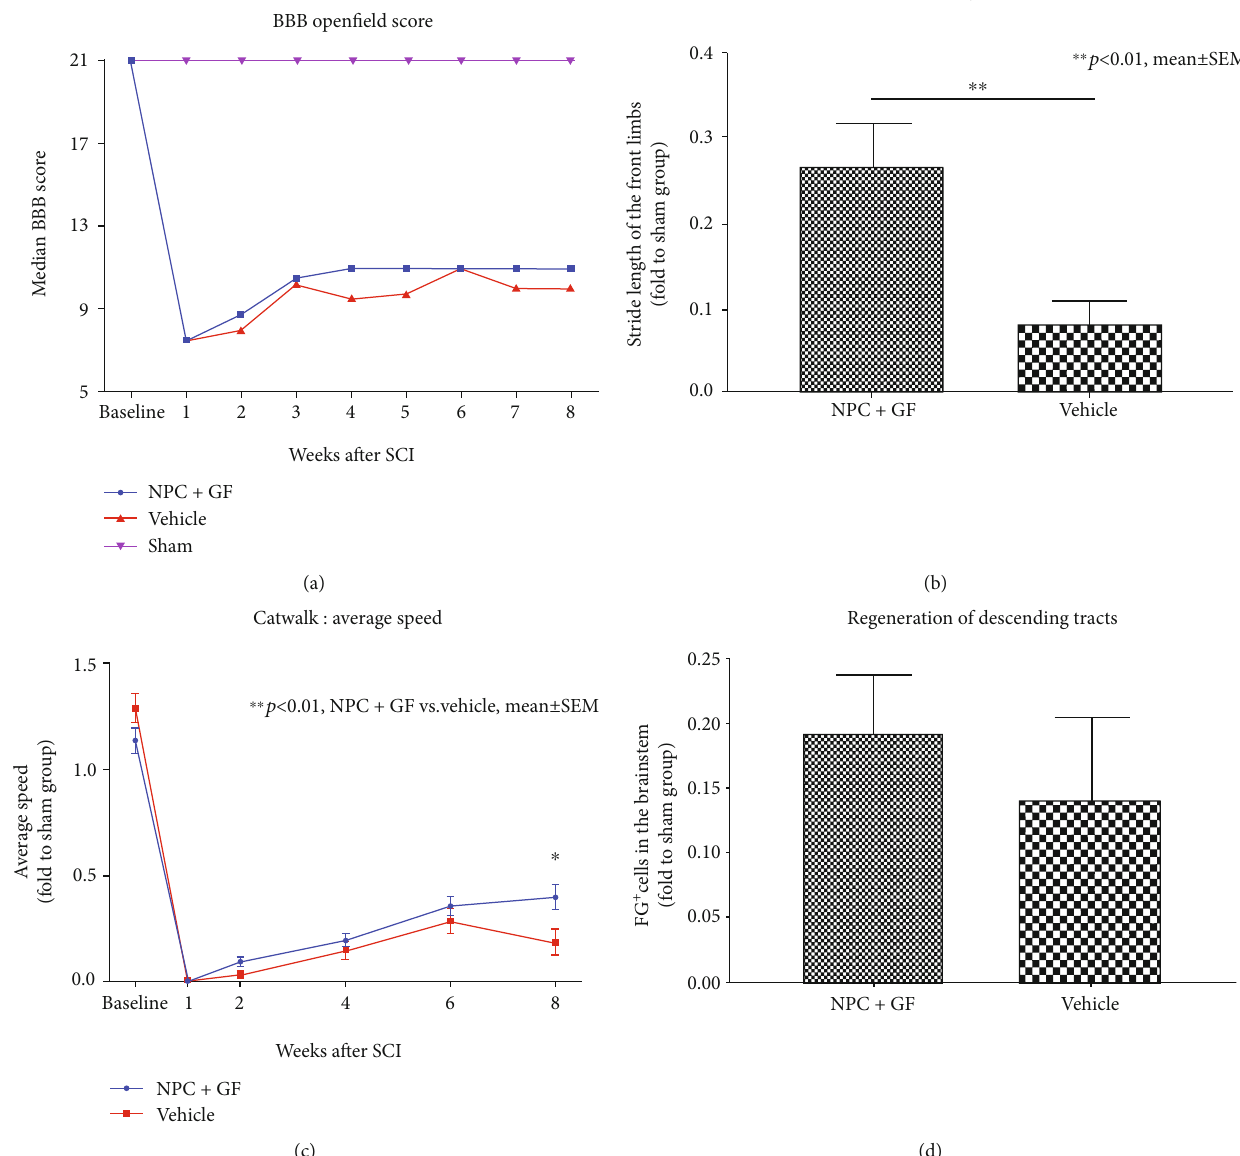
Figure 6: In vivo functional recovery and descending tract regeneration after cervical SCI. (a) Weekly median BBB open fi eld scores. (b) “ Stride Length ” measurement of the CatWalk gait analysis expressed in proportion to (fold to) the sham group 8 weeks after SCI. (c) “ Average Speed ” measurement of the CatWalk gait analysis expressed in proportion to (fold to) the sham group over the course of the experiment. (d) FG + neurons as a surrogate marker for descending tract regeneration expressed in proportion to (fold to) the sham group 8 weeks after the